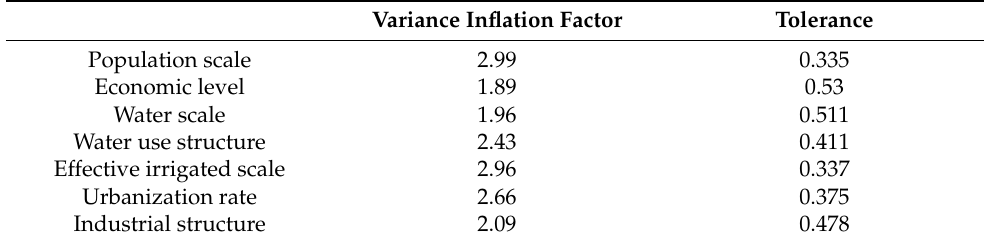
Table 3. Results of multiple collinearity test.